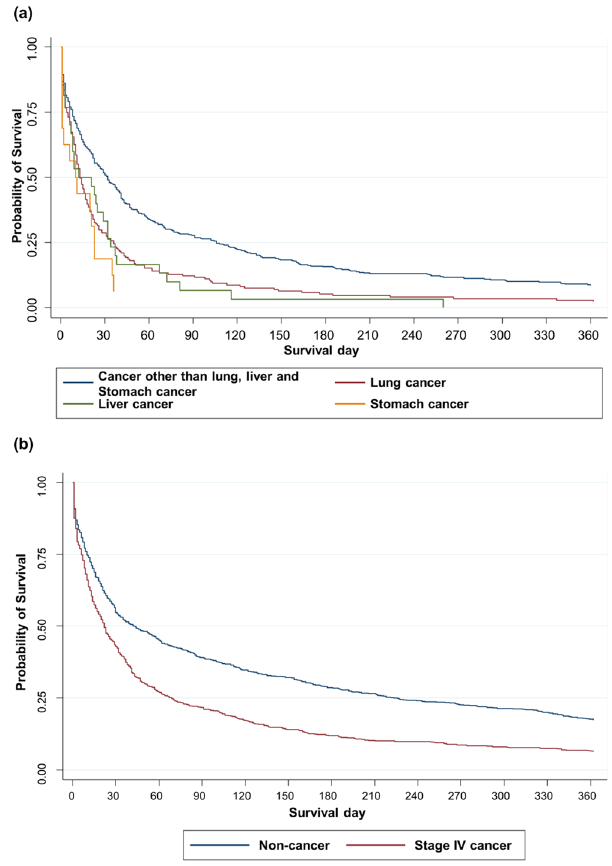
Figure 2. Post-discharge survival curves of liver cancer, stomach cancer, lung cancer and other cancer ( a ), and matched non-cancer and stage IV cancer patients ( b ).